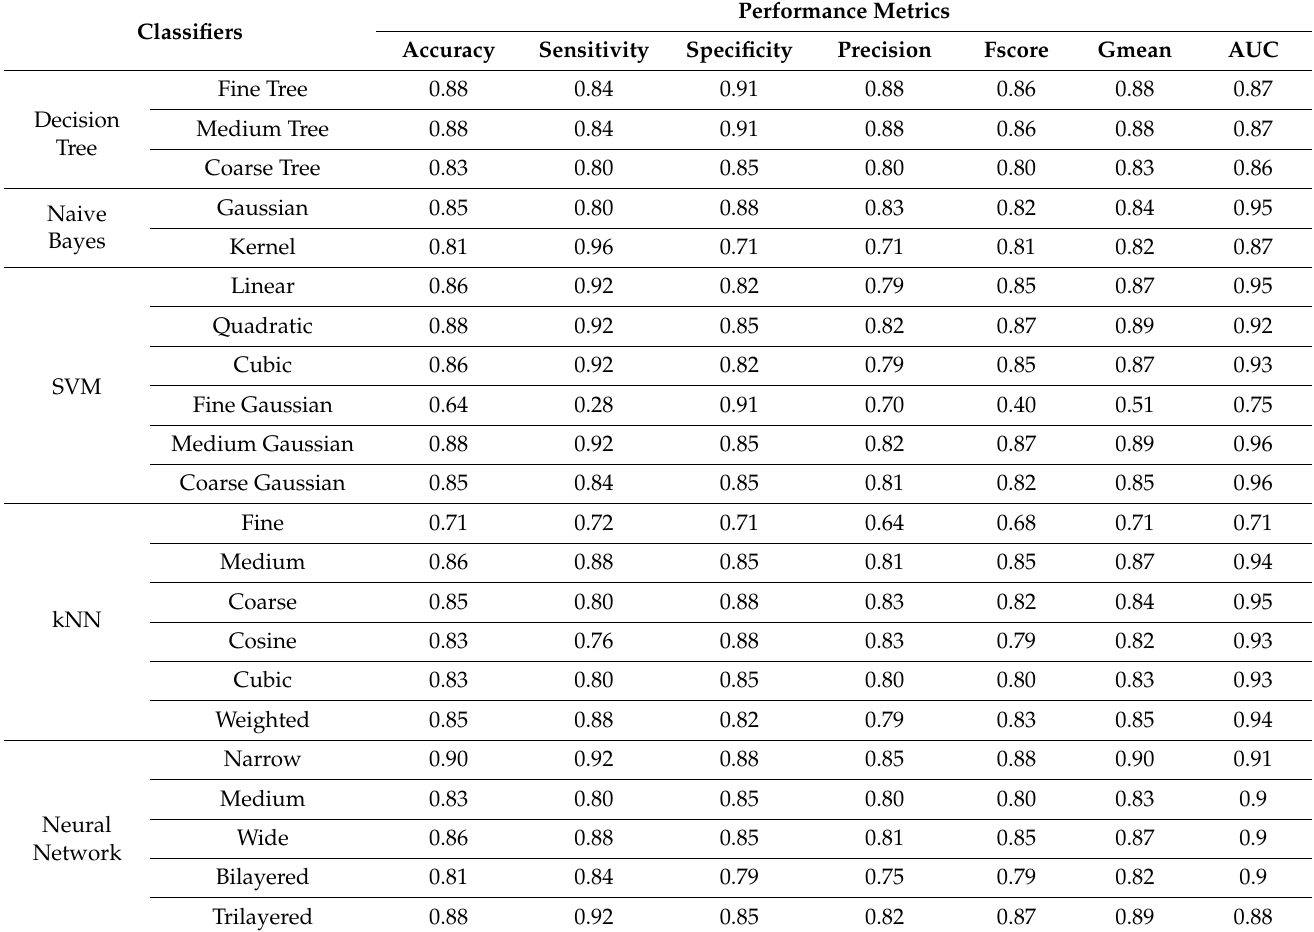
Table 7. Results for the best 25